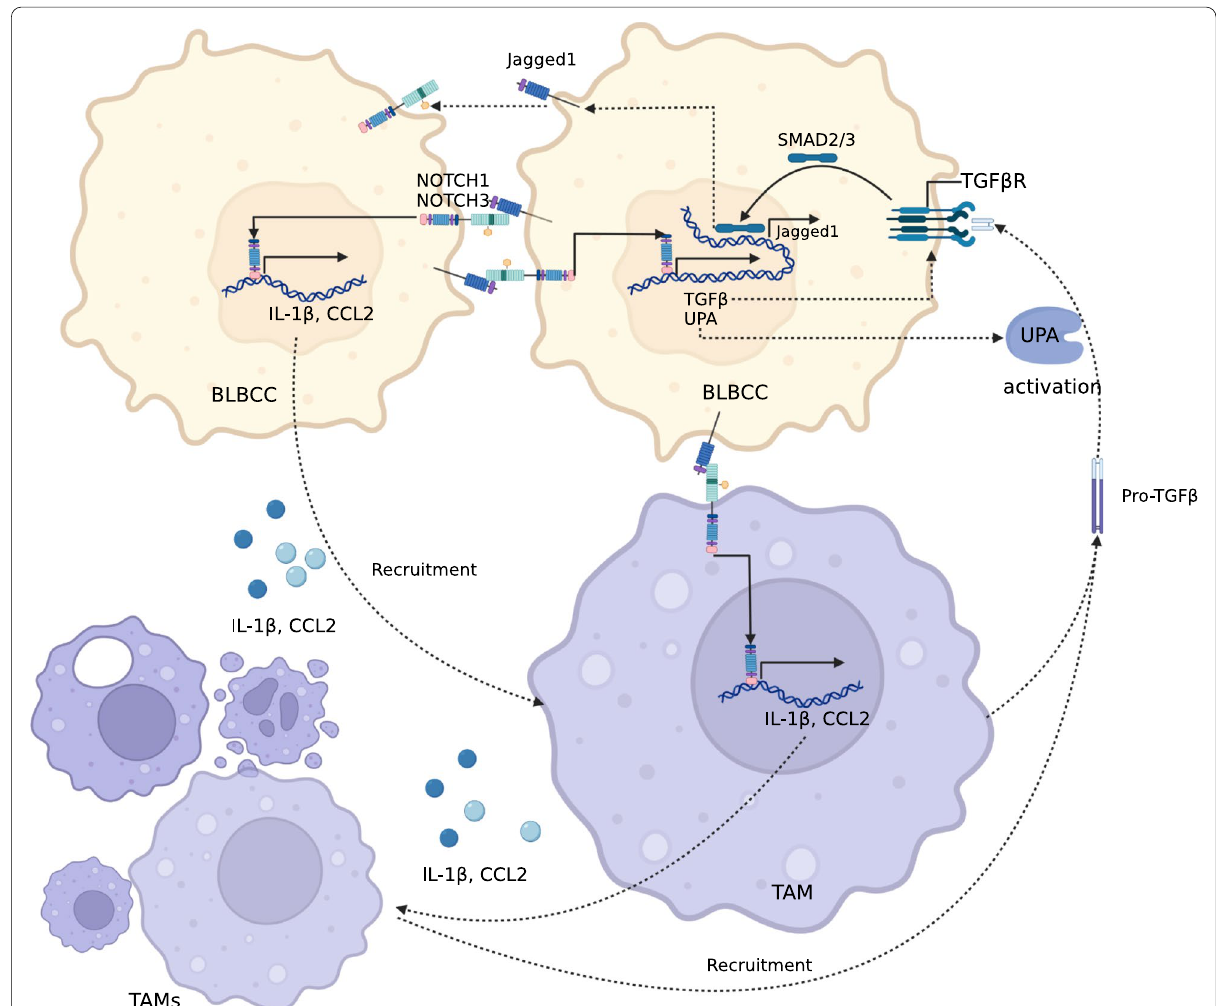
Fig. 3 Notch-mediated paracrine cycle between BLBCC and TAMs. Activated NOTCH1 and NOTCH3 (possibly) upregulate the expression of IL-1β and CCL2 in tumor cells. IL-1β and CCL2 recruit monocytes into the tumor microenvironment to mature into TAMs. TAM-secreted IL-1β and CCL2 recruit more monocytes and TAMs additionally secrete TGFβ-pro. TGFβ-pro is activated by UPA After being TGFβ, it induces Jagged 1 expression in cancer cells through its receptor TGFβR1 in combination with SMAD2/3. Jagged 1 activates NOTCH1 and NOTCH3 (probably), thus upregulating IL-1β and CCL2